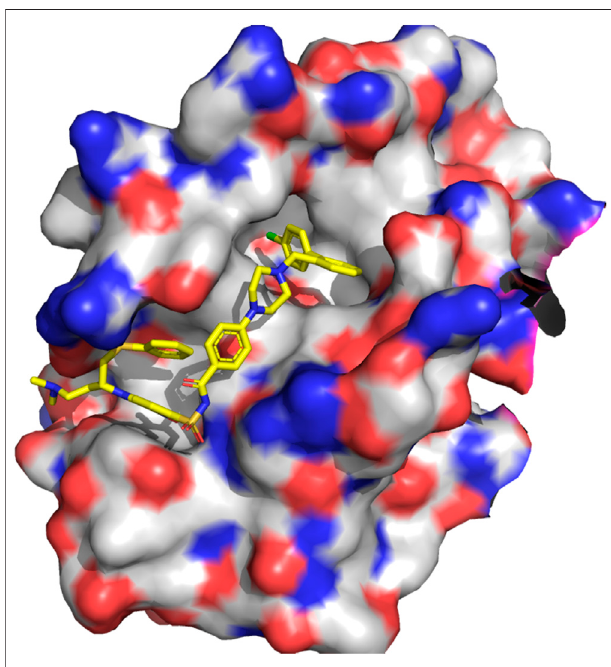
FIGURE 9 | 3D structure of the complex Bcl-xL/ABT-737 (PDB ID: